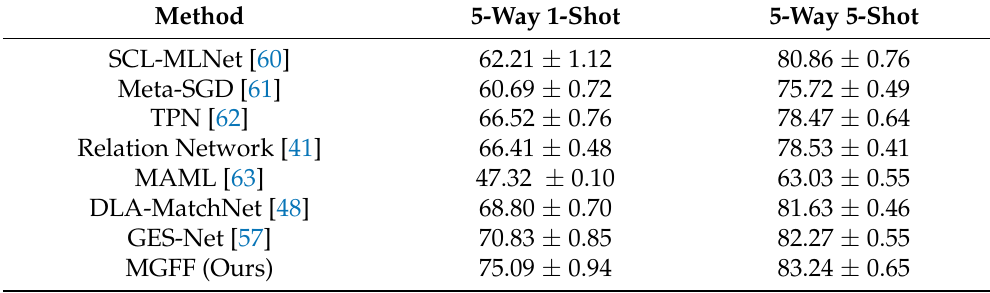
Table 3. Classification accuracies of 5-way 1-shot and 5-way 5-shot on the NWPU-RESISC45 dataset.